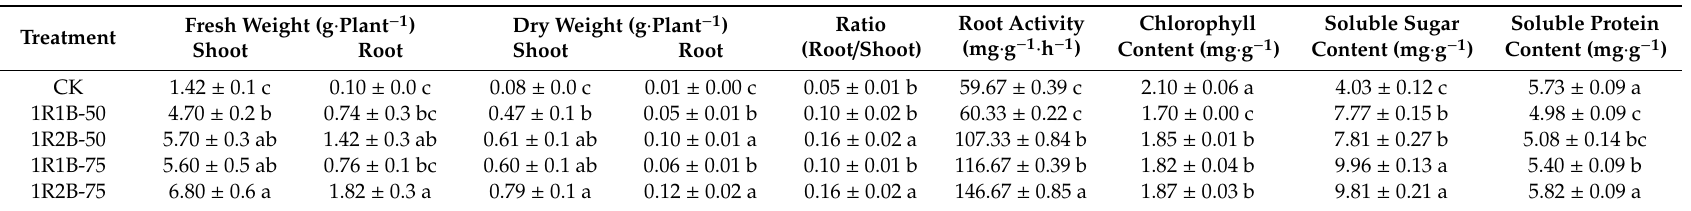
Table 2. E ff ects of RB ratio and intensity of supplemental light on biomass and physiological parameters of cucumber seedlings under extremely low irradiance.